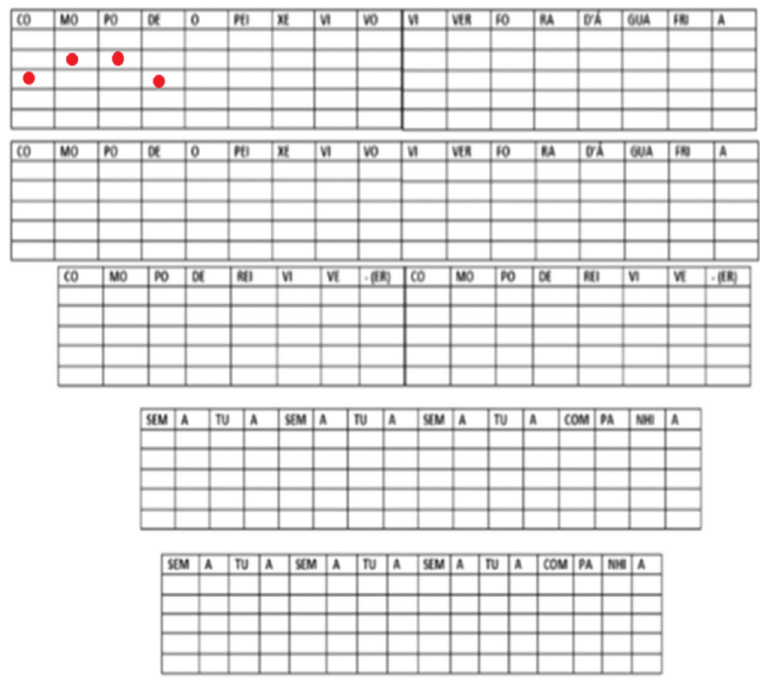
Figure 2 - Example of marking the frequency variation perceived in the first four syllables of the song. Table 1 - Mean and SE for the correct answers (ear-wise) in the DCVT in the NF, FR, and FL conditions and p -values for comparison at M1, M2, and M3.